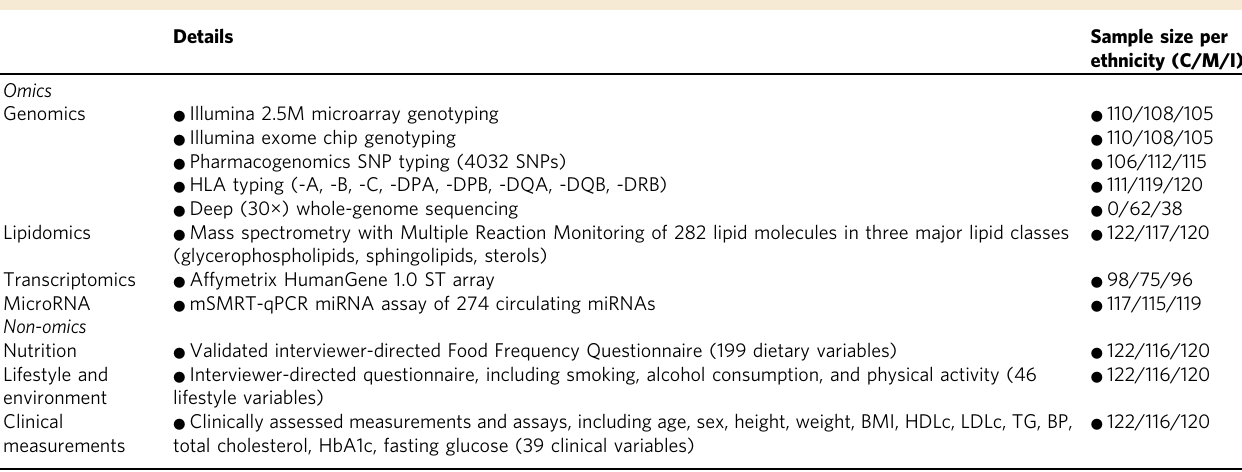
Table 1 Spectrum of omics and non-omics measurements available in the iOmics